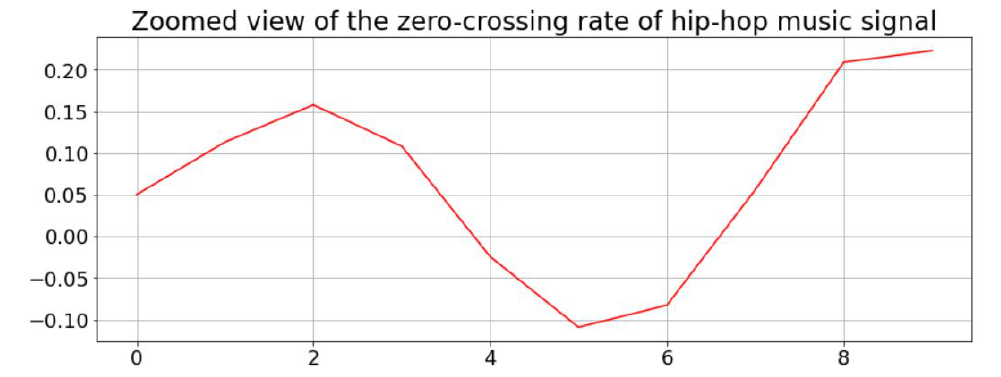
Figure 6. Zoomed view of the zero-crossing rate of hip-hop music signal for ten